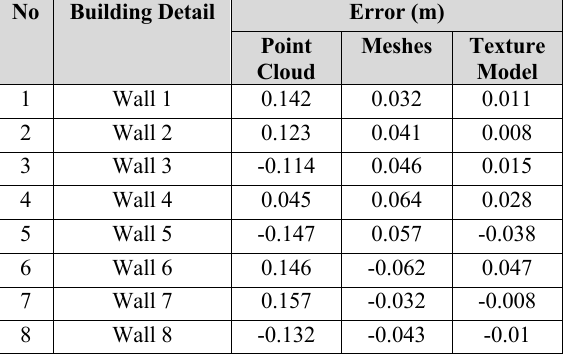
Table 4. Comparison error between point cloud, meshes and texture model.